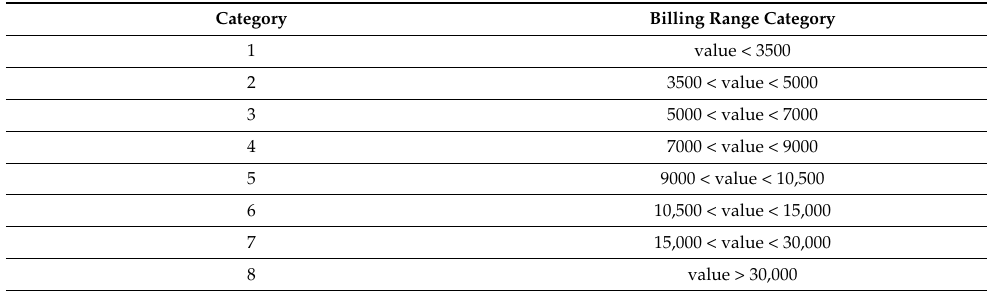
Table 4. Range of predicted values of the ATC